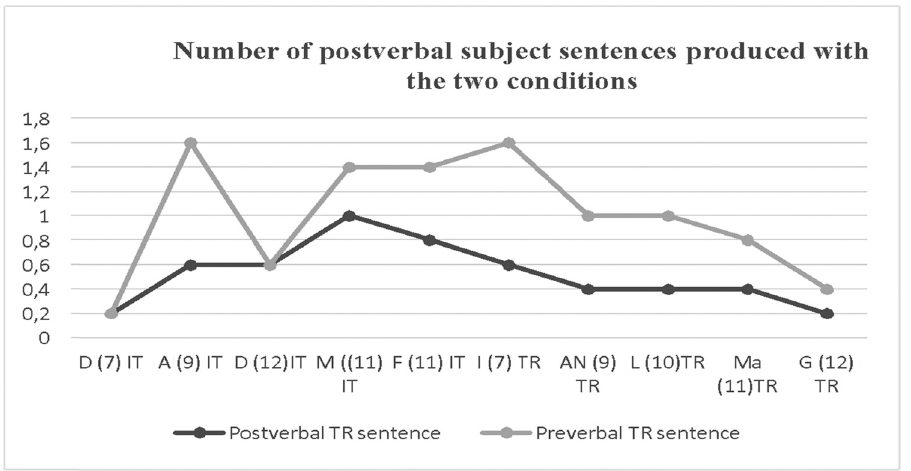
Figure 3: The number of postverbal subject sentences produced in Italian when the Turkish sentence contained either a postverbal or a preverbal subject. Each child is indicated by an abbreviated name, age in parentheses, and school curriculum ( TR for Turkish curriculum school, IT for Italian curriculum )